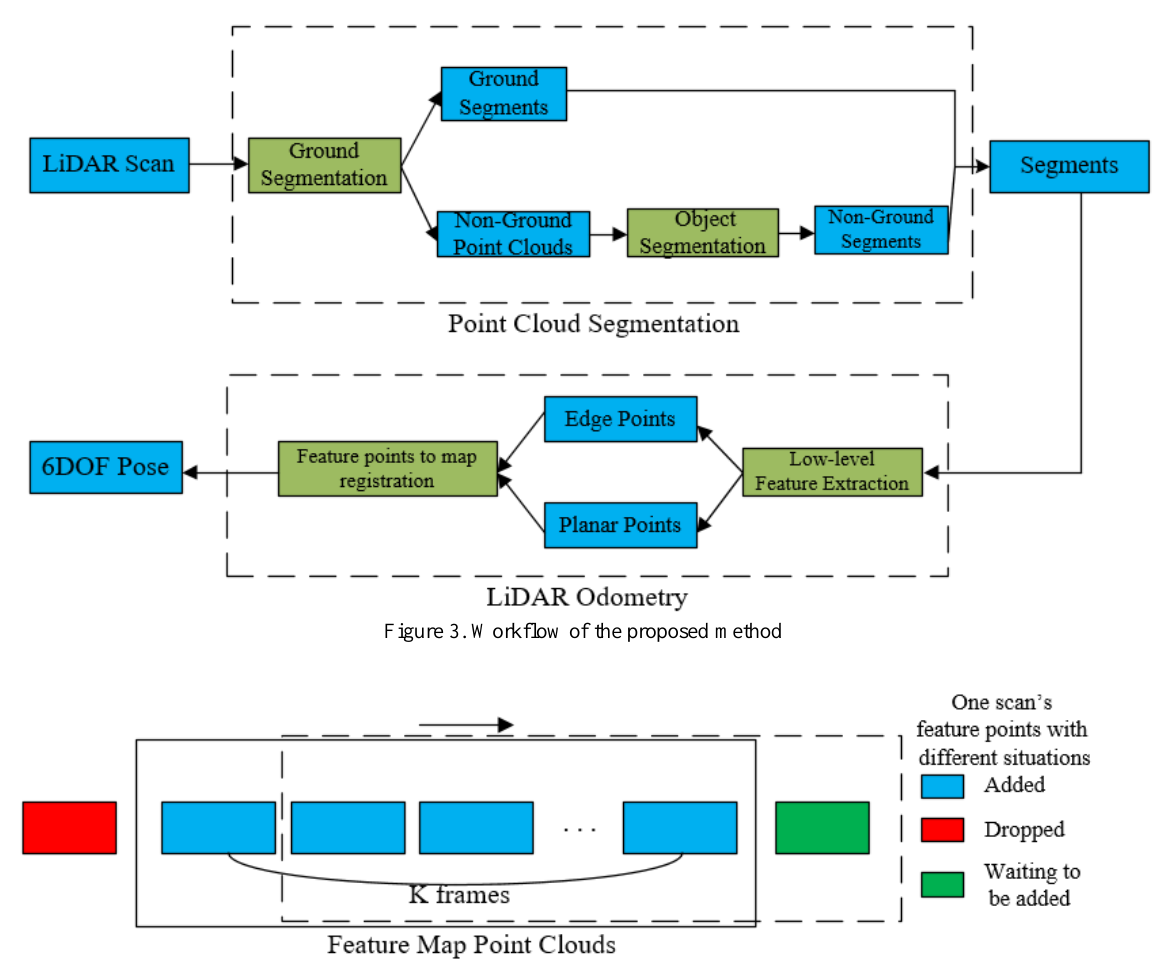
Figure 4. Sliding window based scan matching